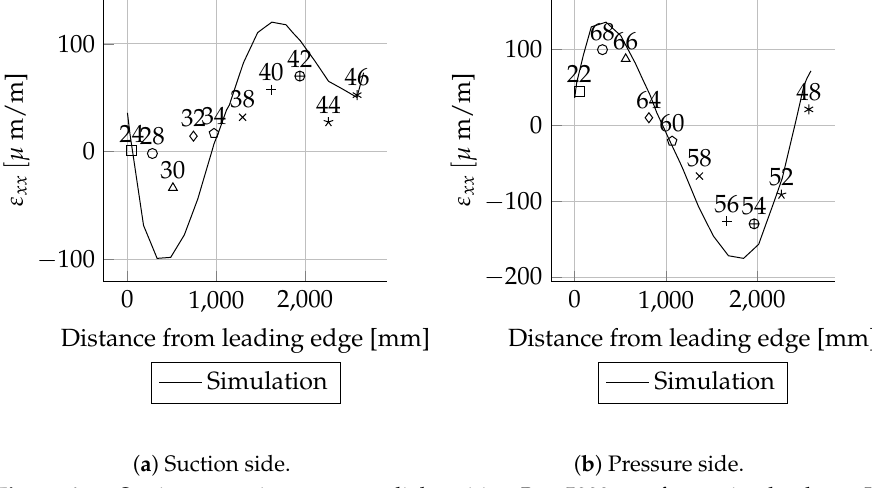
Figure A58. Strain comparison ε LL at radial position R = 5000mm for torsion load case LC_2.